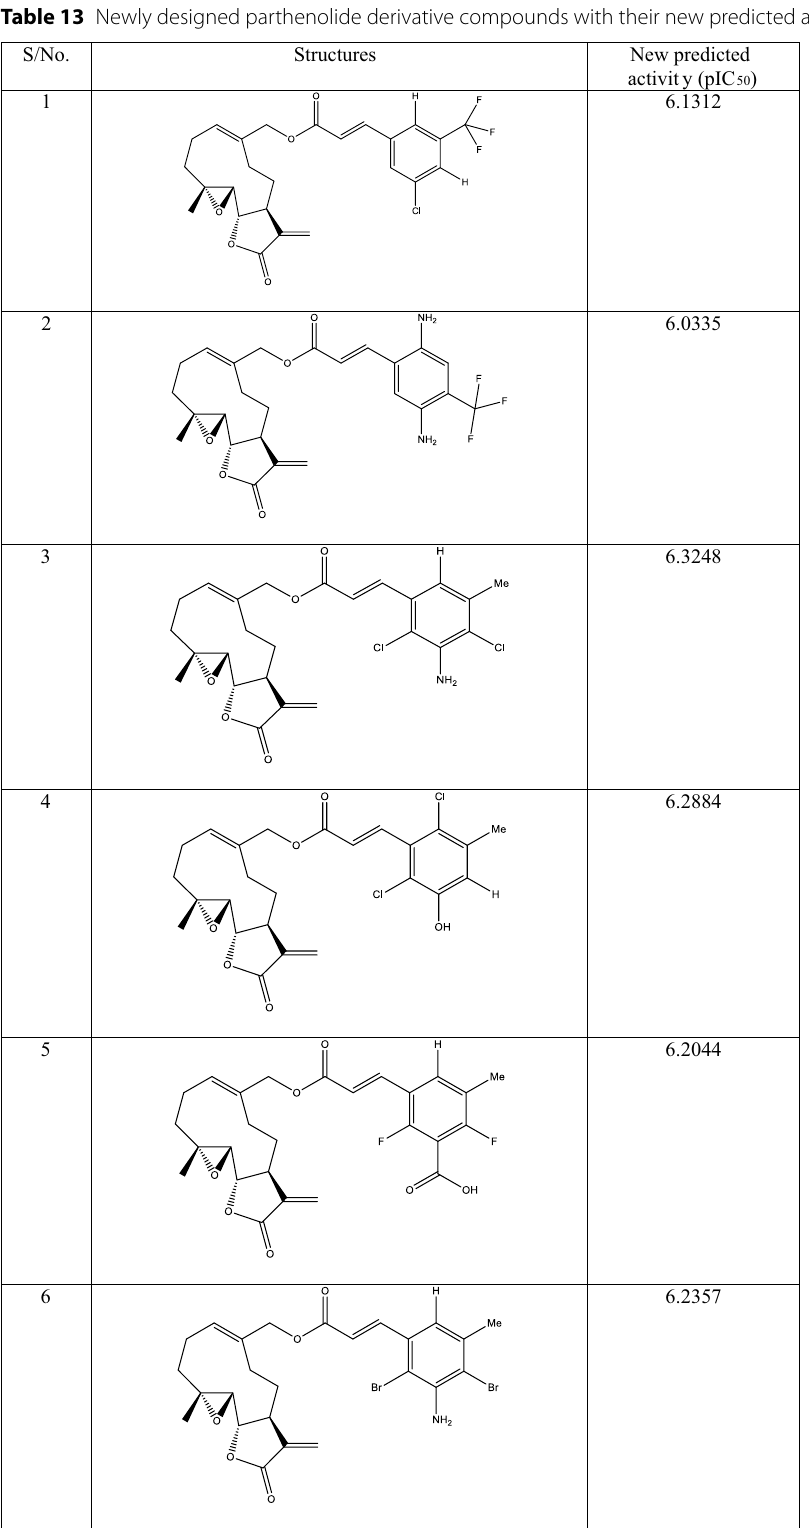
Table 13 Newly designed parthenolide derivative compounds with their new predicted activities (pIC